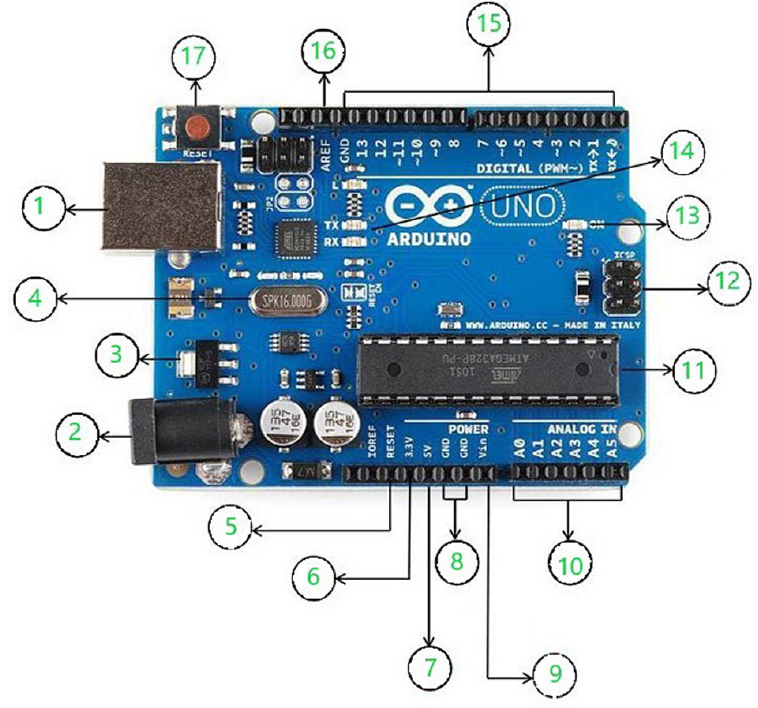
Fig. 5. Arduino plates Uno